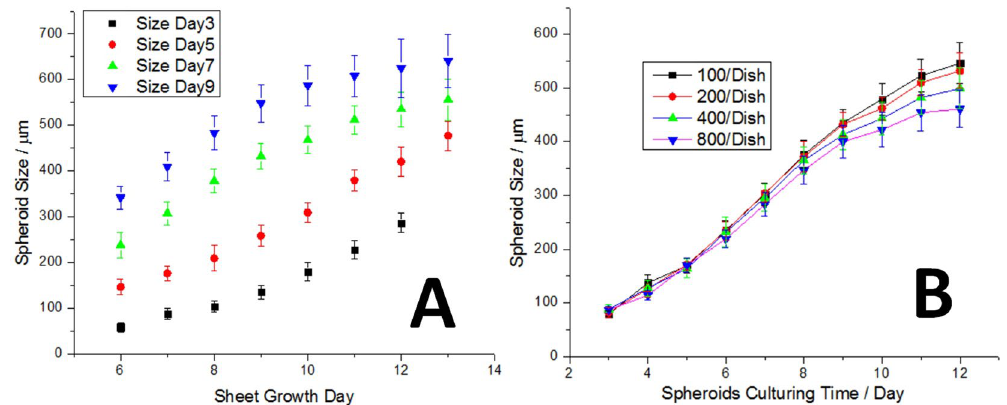
Figure 3. Size control of HCT-116 tumor spheroids. ( A ) Size comparison of spheroids from cell sheets cultured on petri dishes for different times (6 days to 13 days). Spheroid sizes were recorded on different shaking days (black, red, green and blue dots are recorded on shaking day 3, 5, 7, and 9, respectively). ( B ) Size comparison of spheroids from cell sheets that are from different initial cell seeding densities. Spheroid sizes were recorded for 12 days. The tumor spheroids were not perfectly spherical, and the estimation of mean spheroid diameter (D) was suggested by 28 , which was simply calculated as the square root of two orthogonal diameters (d1 and d2) of the spheroids product of longest axis and shortest axis: = D d d 1 2